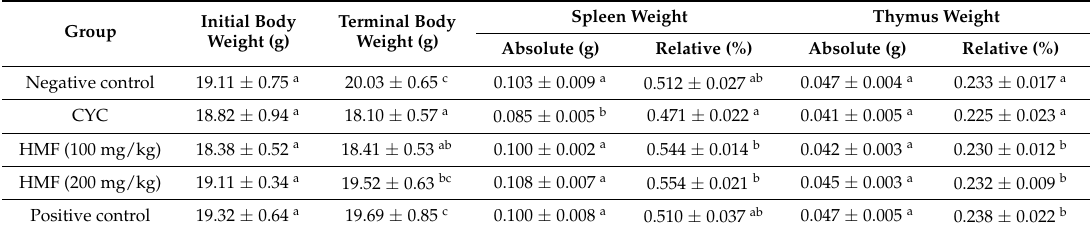
Table 1. Effect of HMF on terminal body weight, absolute and relative organ weights of mice. Spleen Weight Thymus Weight Terminal Body Group Initial Body Weight (g) Weight (g) Absolute (g) Relative (%) Absolute (g) Relative (%) Negative control 19.11 ± 0.75 a 20.03 ± 0.65